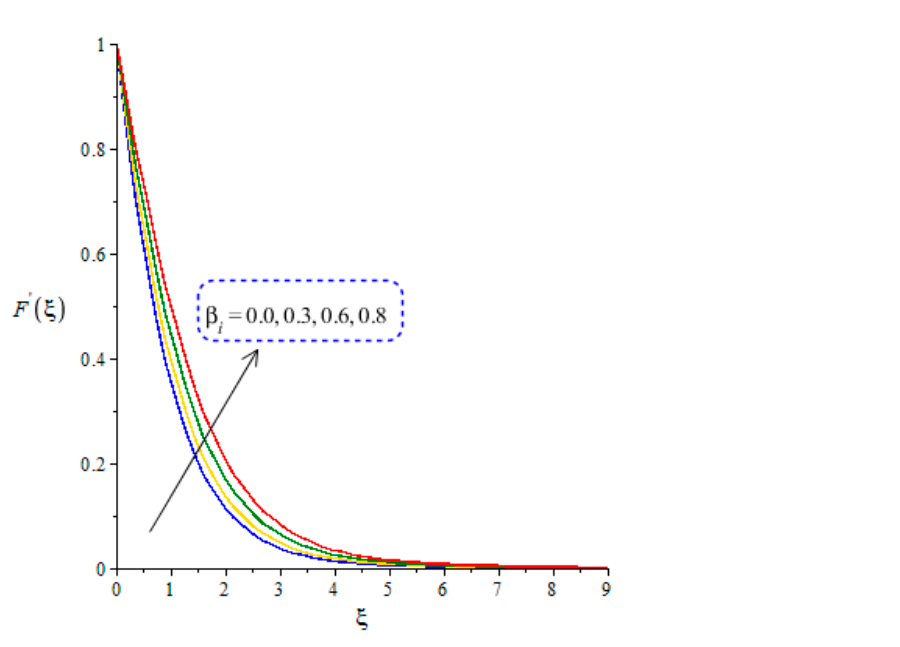
Figure 10. Variation role of F (cid:48) ( ξ ) versus F r when m = 0.1, We = 2.5, Ω = 2.0, M 2 = 0.3, β e = 0.5, Figure 10. Variation role of 𝐹′(𝜉) versus 𝐹 (cid:3045) when 𝑚 = 0.1, 𝑊𝑒 = 2.5, Ω = 2.0, 𝑀 (cid:2870) = 0.3,𝛽 (cid:3032) = (cid:101) = 0.1, F r = 2.5, Pr = 204, Ec = 0.3, ϕ 2 = 0.0075, ϕ 1 = 0.002, ϕ 3 = 0.005. 0.5, 𝜖 = 0.1, 𝐹 (cid:3045) = 2.5, 𝑃𝑟 = 204, 𝐸𝑐 = 0.3,𝜑 (cid:2870) = 0.0075, 𝜑 (cid:2869) = 0.002,𝜑 (cid:2871) = 0.005.